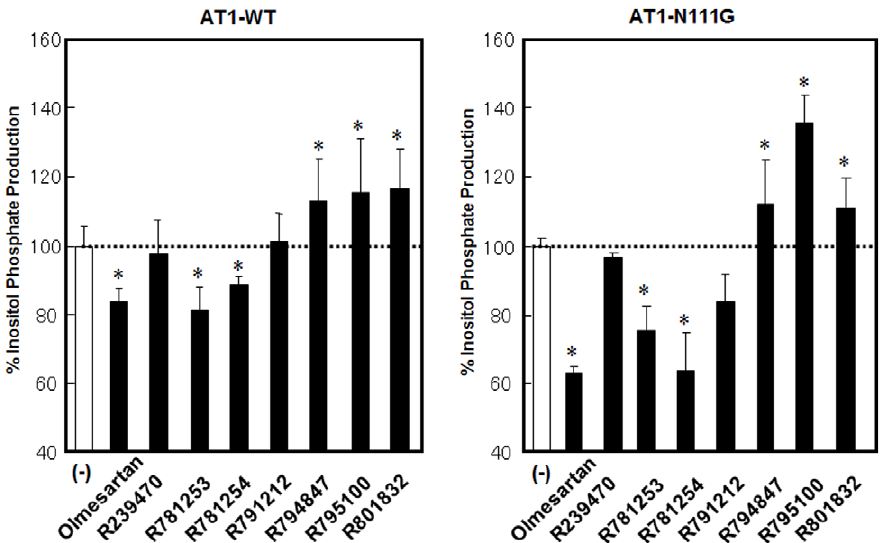
Figure 2. % inositol phosphate (IP) production with or without 1 m M of olmesartan and olmesartan-related compounds in COS1 cells transiently expressing the wild-type (WT) and N111G AT 1 receptor. The test compounds were added 1 h before the measurement of IP. 100% IP production indicates basal IP production in WT (1,033 6 149 cpm) and N111G (2,087 6 414 cpm) AT 1 receptor-transfected cells. Ang II (0.1 m M)-induced maximum IP production in WT and N111G AT 1 receptor-transfected cells were 4,037 6 479 cpm and 4,138 6 362 cpm, respectively. n=4–7, *p , 0.05 vs. no treatment.